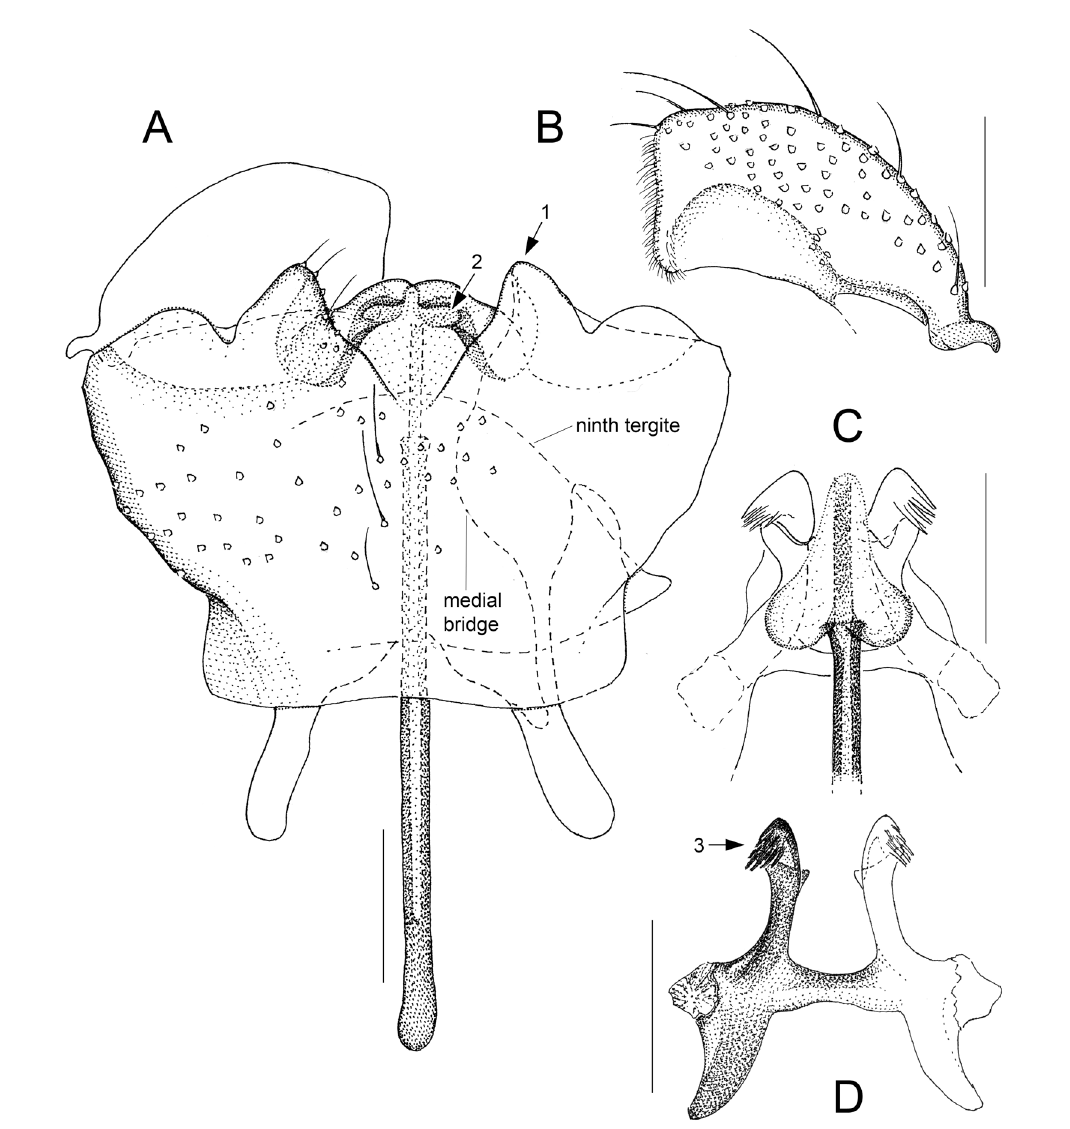
Fig. 3. Glemparon tomelilla sp. nov., ♂♂. A–C . holotype (NhRS, no. CEC1406). A . Genitalia, ventral. B . Gonostylus, ventral. C . Apex of ejaculatory apodeme, tegmen indicated, ventral. D . Tegmen, ventral, paratype (NhRS, no. CEC1407). Scale bars = 0.05 mm. Numbered arrows indicate diagnostic characters (see